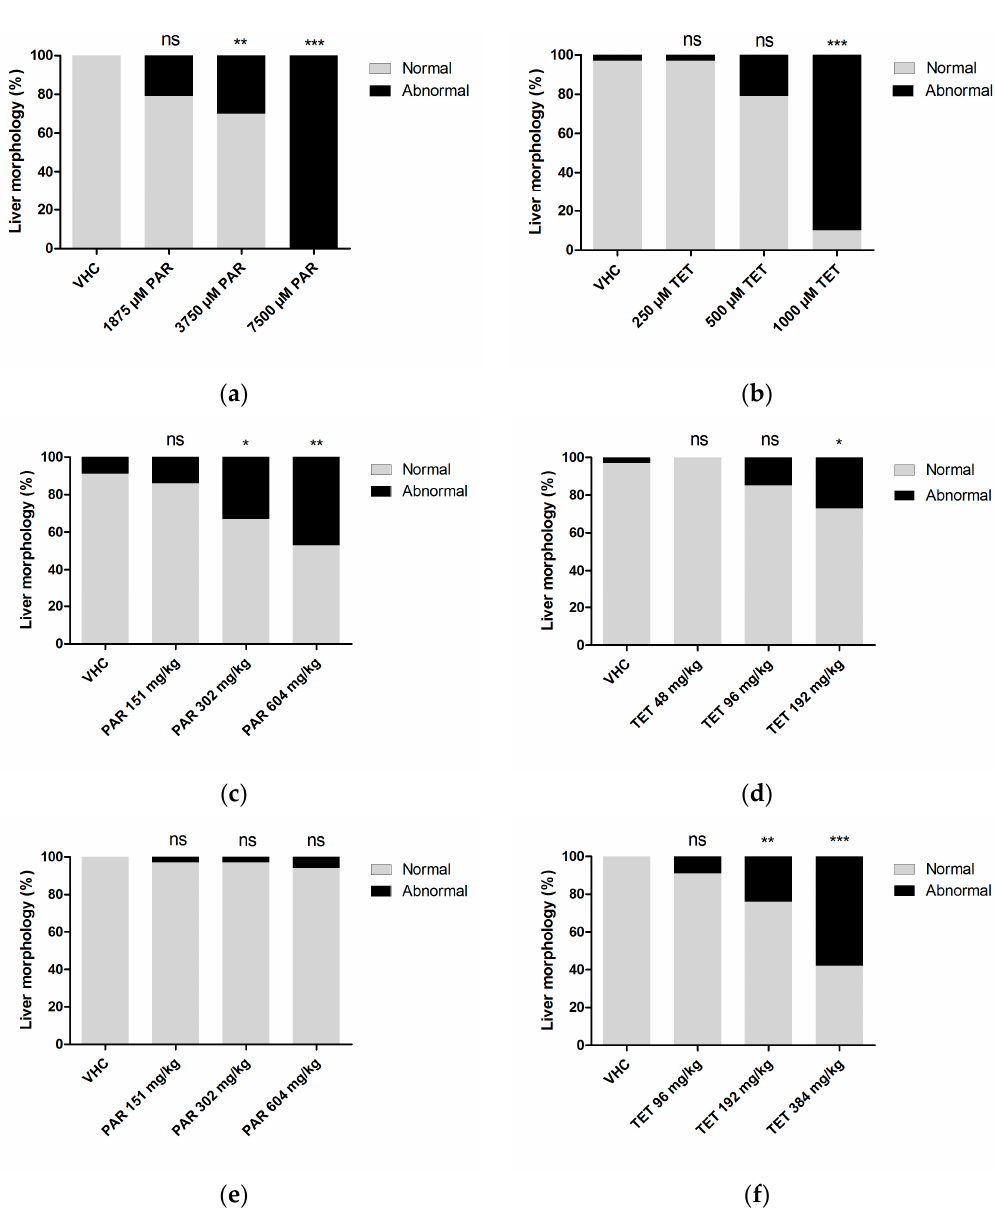
Figure 3. Hepatotoxicity assessed by visual analysis of liver morphology (by researchers blinded for the treatment conditions) using fluorescence microscopy after immersion ( a , b ); yolk injection ( c , d ) and pericardial injection ( e , f ) of paracetamol ( a , c , e ) and tetracycline ( b , d , f ). Analysis was performed after three days of treatment (immersion) or three days after treatment (injection), at 6 dpf. A total of 10 and 12 larvae were used individually per condition for immersion and injections, respectively. The experiment was performed in triplicate and data were pooled. The results are expressed as the percentage of larvae having normal or abnormal liver morphology. The data were analyzed by Fisher’s exact test. ns: no statistically significant difference; *: p < 0.05; **: p < 0.01: ***: p < 0.001; VHC: vehicle control; PAR: paracetamol; TET: tetracycline.